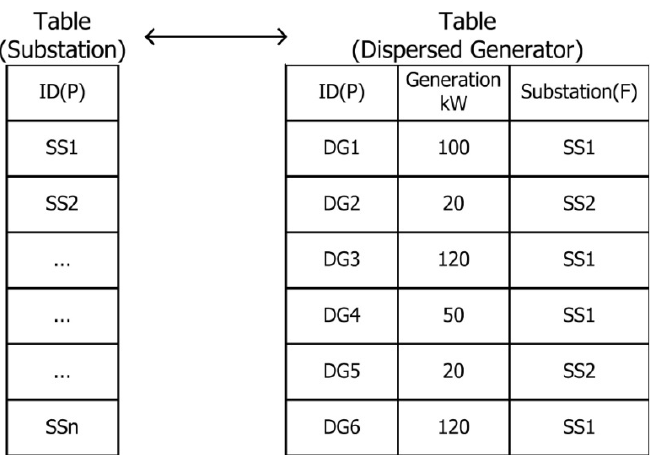
Figure 3. Example of ID structure